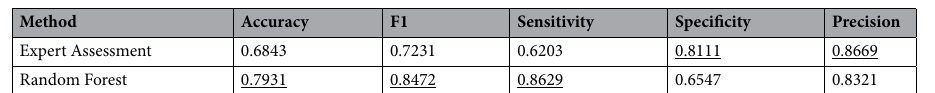
Table 4. The comparison of five prediction measurements between expert assessment and random forest. The expert assessment is the majority vote of three surgeons’ judgments. The highest values between the experts and model are